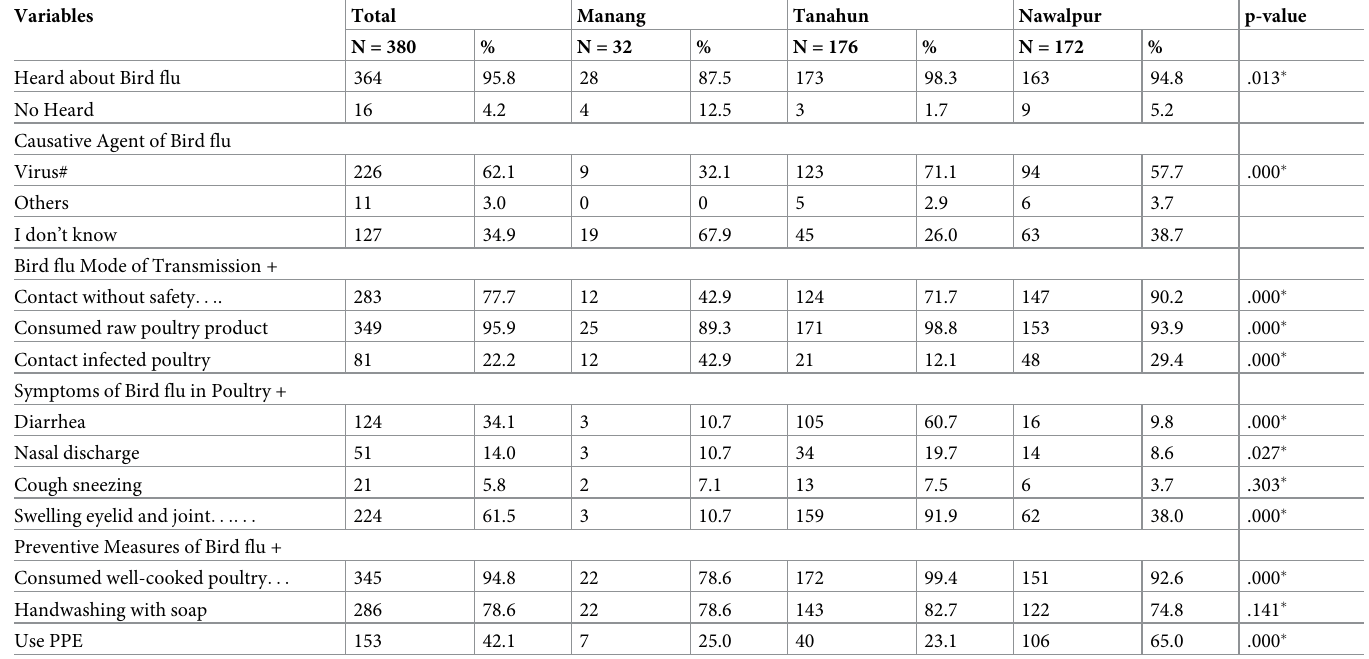
Table 3. Bird flu; knowledge based on ecological regions of the